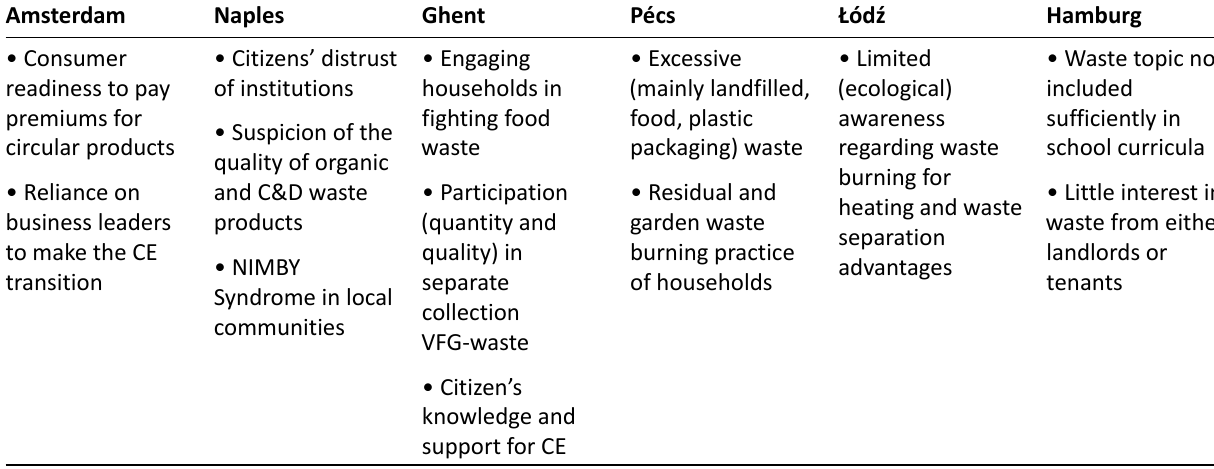
Table 4. Governance challenges: